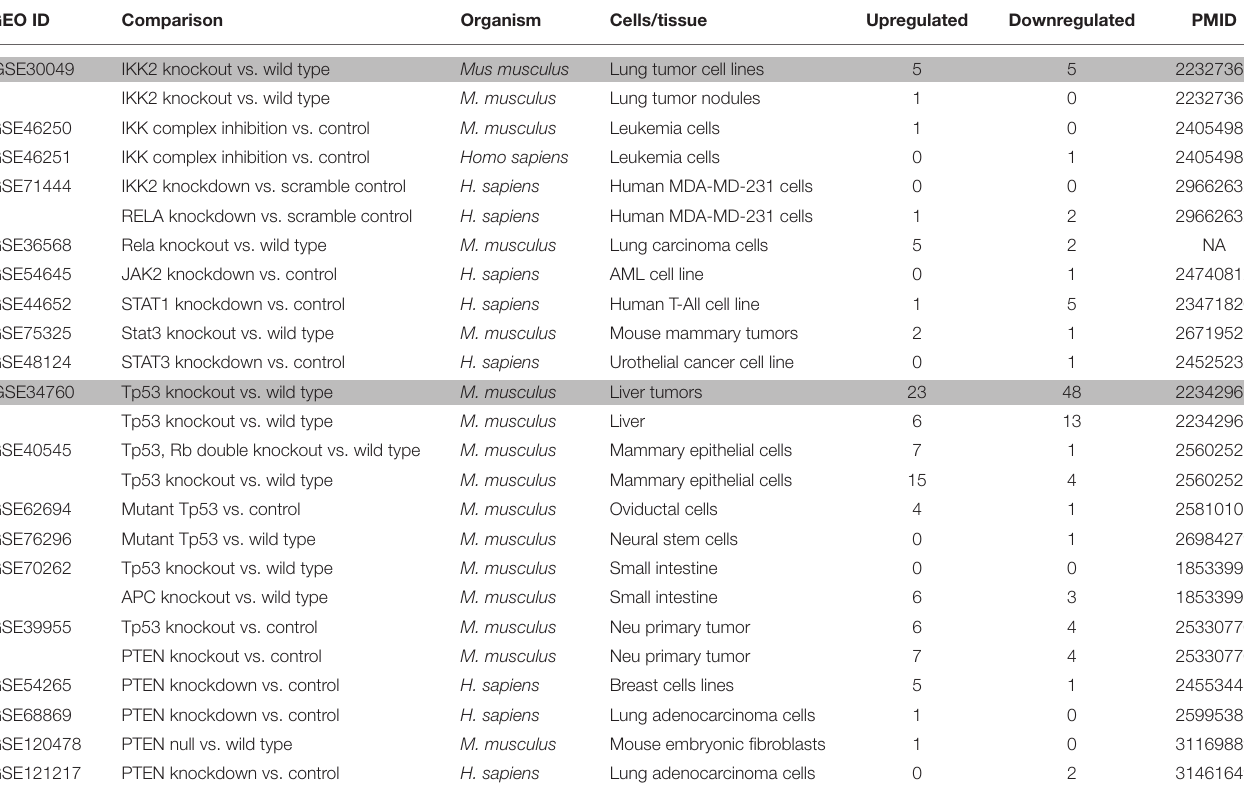
TABLE 11 | Nineteen microarrays of deficiencies of oncogene and tumor suppressor in the National Institutes of Health (NIH)–National Center for Biotechnology Information (NCBI)–Gene Expression Omnibus (GEO) datasets database (https://www.ncbi.nlm.nih.gov/gds/) were collected to analyze the expression changes